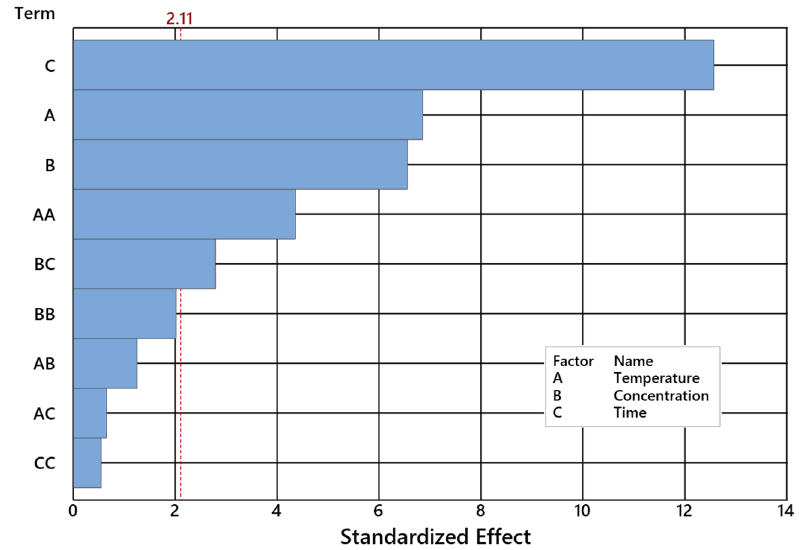
Figure 5. Levels of important and not important factors of the of dimethyl selectivity for α = 0.05. Table 3. Model summary of NE selectivity.